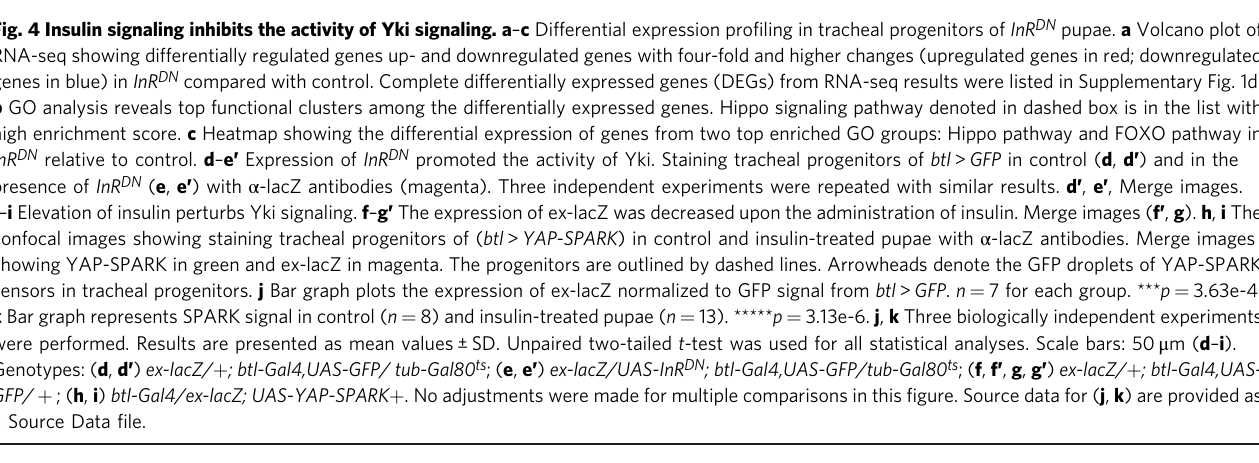
Fig. 4 Insulin signaling inhibits the activity of Yki signaling. a – c Differential expression pro fi ling in tracheal progenitors of InR DN pupae. a Volcano plot of RNA-seq showing differentially regulated genes up- and downregulated genes with four-fold and higher changes (upregulated genes in red; downregulated genes in blue) in InR DN compared with control. Complete differentially expressed genes (DEGs) from RNA-seq results were listed in Supplementary Fig. 1d. b GO analysis reveals top functional clusters among the differentially expressed genes. Hippo signaling pathway denoted in dashed box is in the list with high enrichment score. c Heatmap showing the differential expression of genes from two top enriched GO groups: Hippo pathway and FOXO pathway in InR DN relative to control. d – e ’ Expression of InR DN promoted the activity of Yki. Staining tracheal progenitors of btl > GFP in control ( d , d ’ ) and in the presence of InR DN ( e , e ’ ) with α -lacZ antibodies (magenta). Three independent experiments were repeated with similar results. d ’ , e ’ , Merge images. f – i Elevation of insulin perturbs Yki signaling. f – g ’ The expression of ex-lacZ was decreased upon the administration of insulin. Merge images ( f ’ , g ). h , i The confocal images showing staining tracheal progenitors of ( btl > YAP-SPARK ) in control and insulin-treated pupae with α -lacZ antibodies. Merge images showing YAP-SPARK in green and ex-lacZ in magenta. The progenitors are outlined by dashed lines. Arrowheads denote the GFP droplets of YAP-SPARK sensors in tracheal progenitors. j Bar graph plots the expression of ex-lacZ normalized to GFP signal from btl > GFP . n = 7 for each group. *** p = 3.63e-4. k Bar graph represents SPARK signal in control ( n = 8) and insulin-treated pupae ( n = 13). ***** p = 3.13e-6. j , k Three biologically independent experiments were performed. Results are presented as mean values± SD. Unpaired two-tailed t -test was used for all statistical analyses. Scale bars: 50 μ m ( d – i ). Genotypes: ( d , d ’ ) ex-lacZ/ + ; btl-Gal4,UAS-GFP/ tub-Gal80 ts ; ( e , e ’ ) ex-lacZ/UAS-InR DN ; btl-Gal4,UAS-GFP/tub-Gal80 ts ; ( f , f ’ , g , g ’ ) ex-lacZ/ + ; btl-Gal4,UAS- GFP/